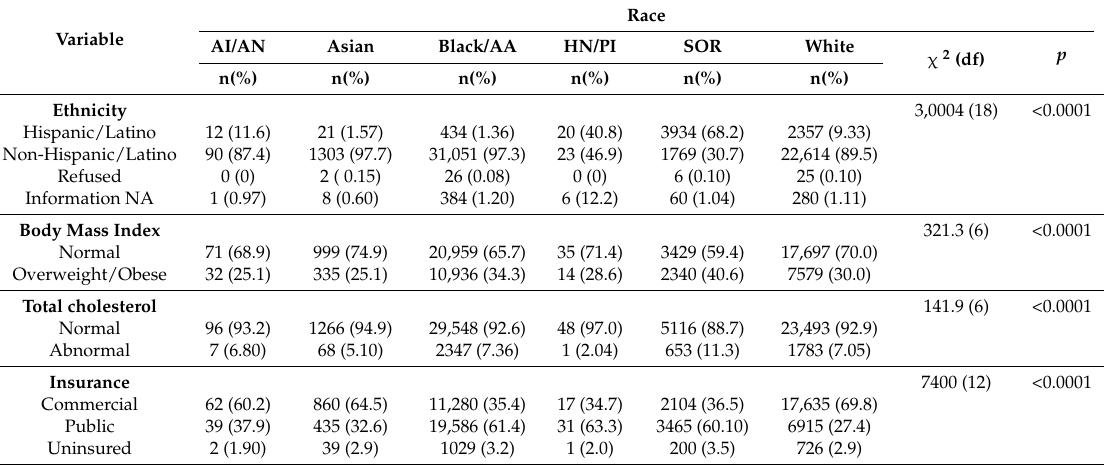
Table 2. Study characteristics by race (categorical variables).